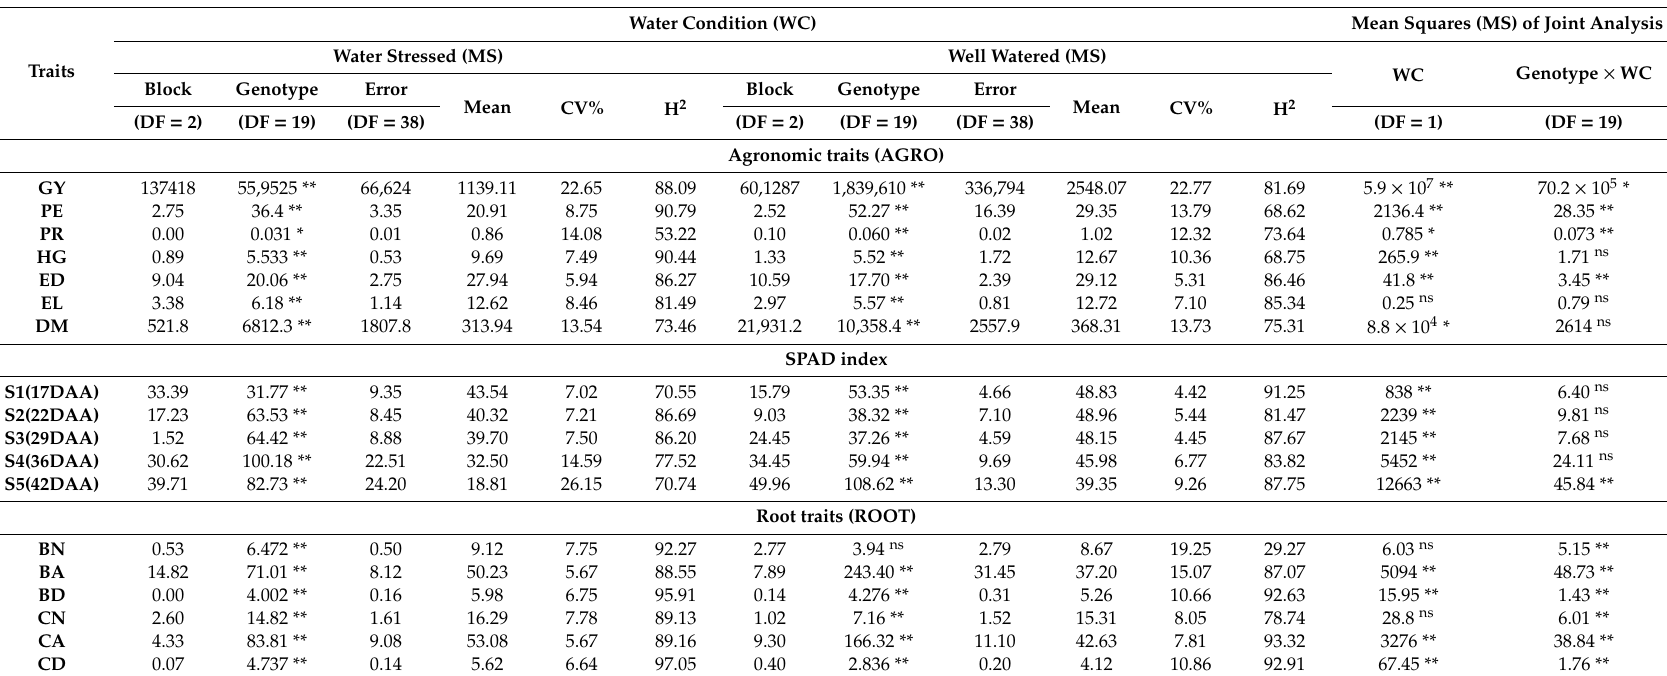
Table 1. Summary of analysis of variance, means, coe ffi cients of variation (CV), and coe ffi cient of genotypic determination of agronomic traits (H 2 ), di ff erent dates of measurement of greenness (SPAD index), and traits related to the root system evaluated in popcorn lines under water-stressed (WS) and well-watered (WW)